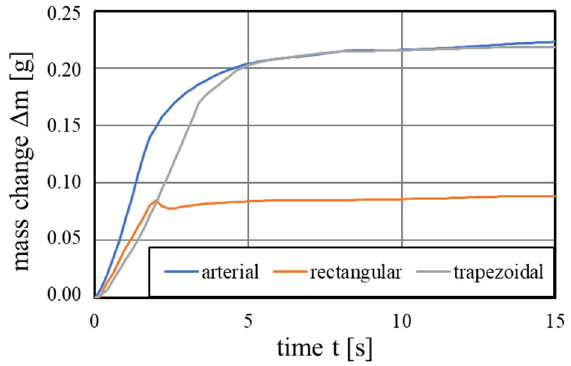
Figure 12. Capillary pumping mass of the vertically printed grooved wicks with the printing parameter 5.